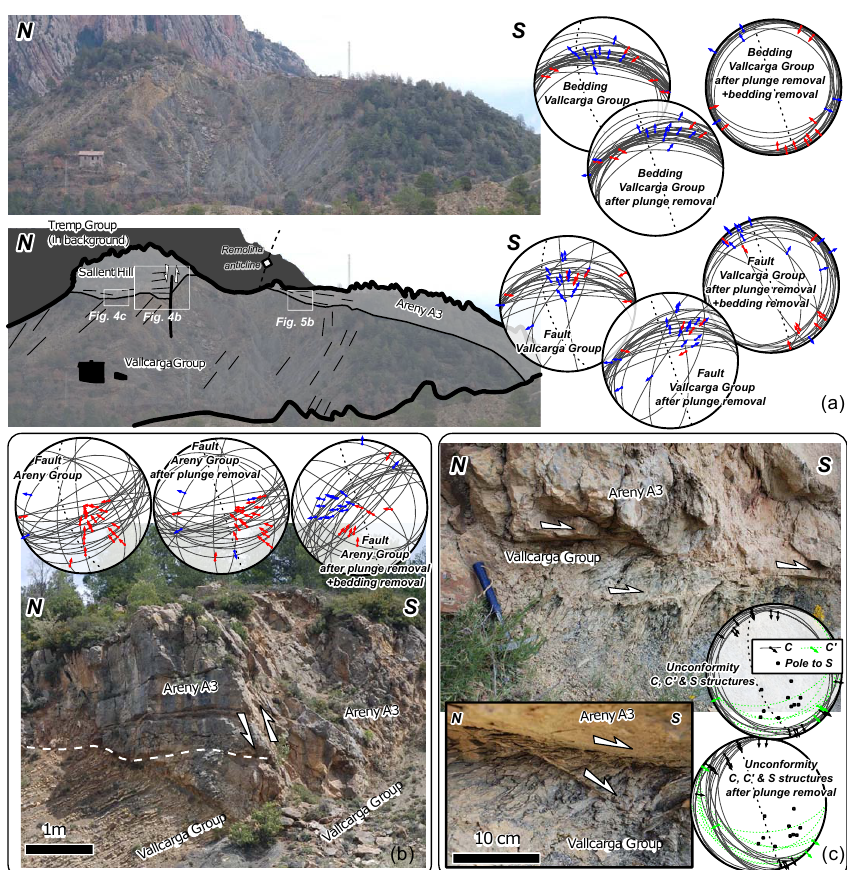
Figure 4. Macro- and meso-structures of the Remolina anticline. (a) Panoramic view and line-drawing of the Remolina anticline (with insets showing the location of (b) and (c) , and Fig. 5b), with stereoplots of faults and bedding measured in the Vallcarga Group. (b) Detail of a south-dipping reverse fault with sub-horizontal carbonates of the Areny Group on top of overturned strata of the Vallcarga Group in its footwall. Stereoplots show fault data in the Areny carbonates. (c) Details of the unconformity, with S–C–C’ illustrated and